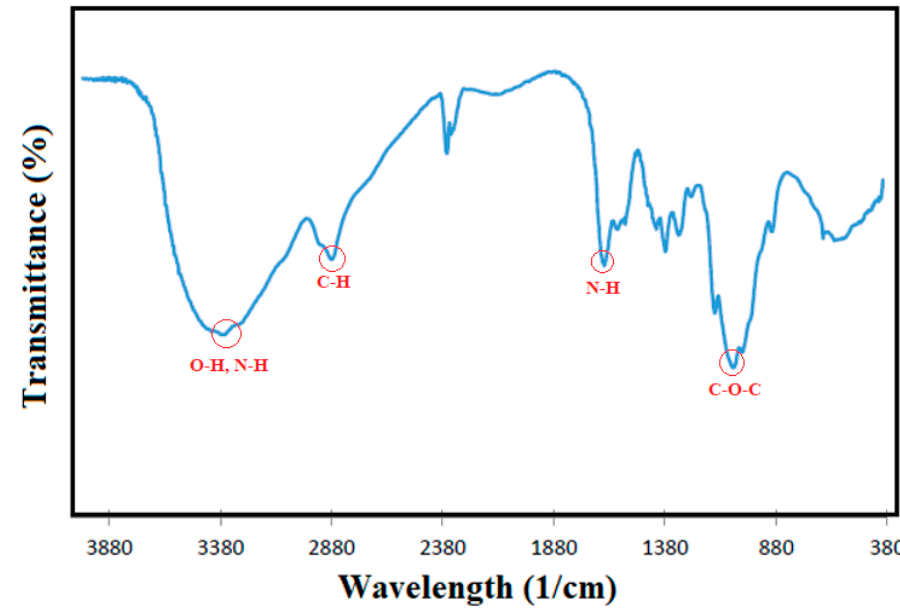
Figure 3. Fourier transform infrared (FTIR) spectrum of chitosan, reproduced from [25].